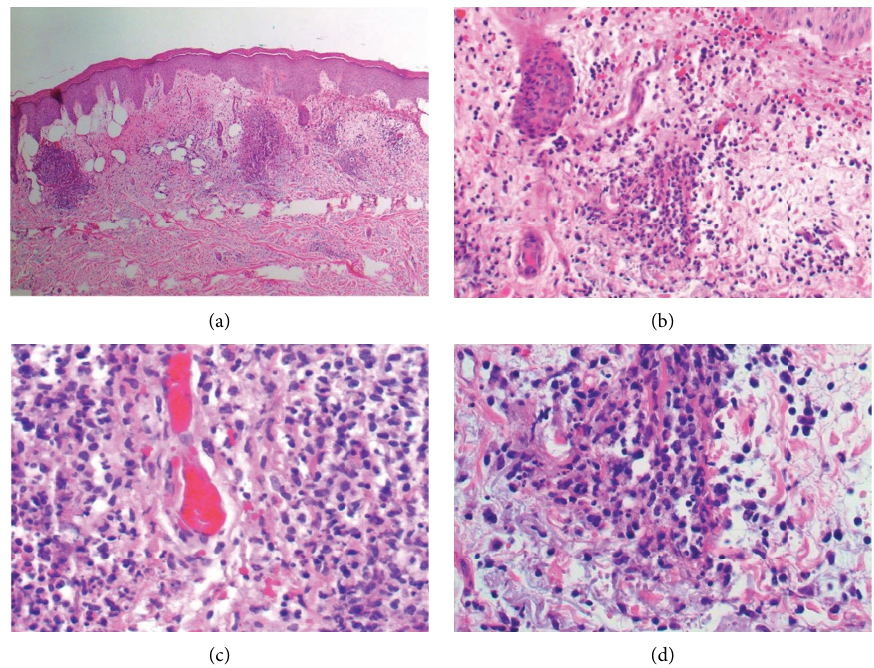
Figure 2: Histology on low (hematoxylin-eosin stain; original magnifcations: (a) x 20) and high (hematoxylin-eosin stain; original magnifcations: (b) x 200) power show a moderately dense perivascular and interstitial infammatory infltrate composed of lymphocytes, histiocytes, and numerous neutrophils with surrounding papillary dermal edema. (c)/(d). High power views demonstrate scattered nuclear dust (karyorrhexis) and fbrin within the walls of the small blood vessels with extravasation of red blood cells in the surrounding stroma (hematoxylin-eosin stain; original magnifcations: (c) x 400; (d) x